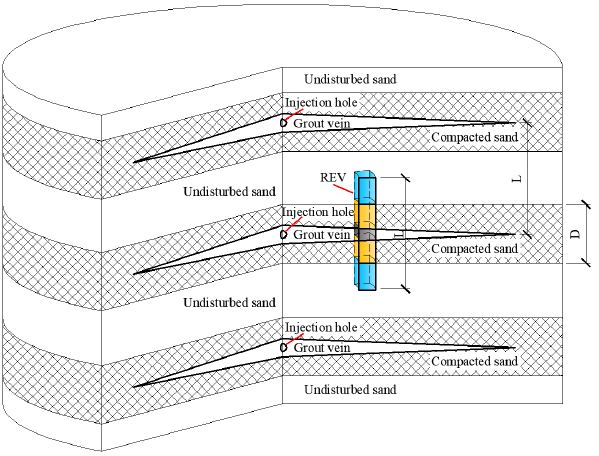
Figure 6. Simplified calculation model of grouting effect.